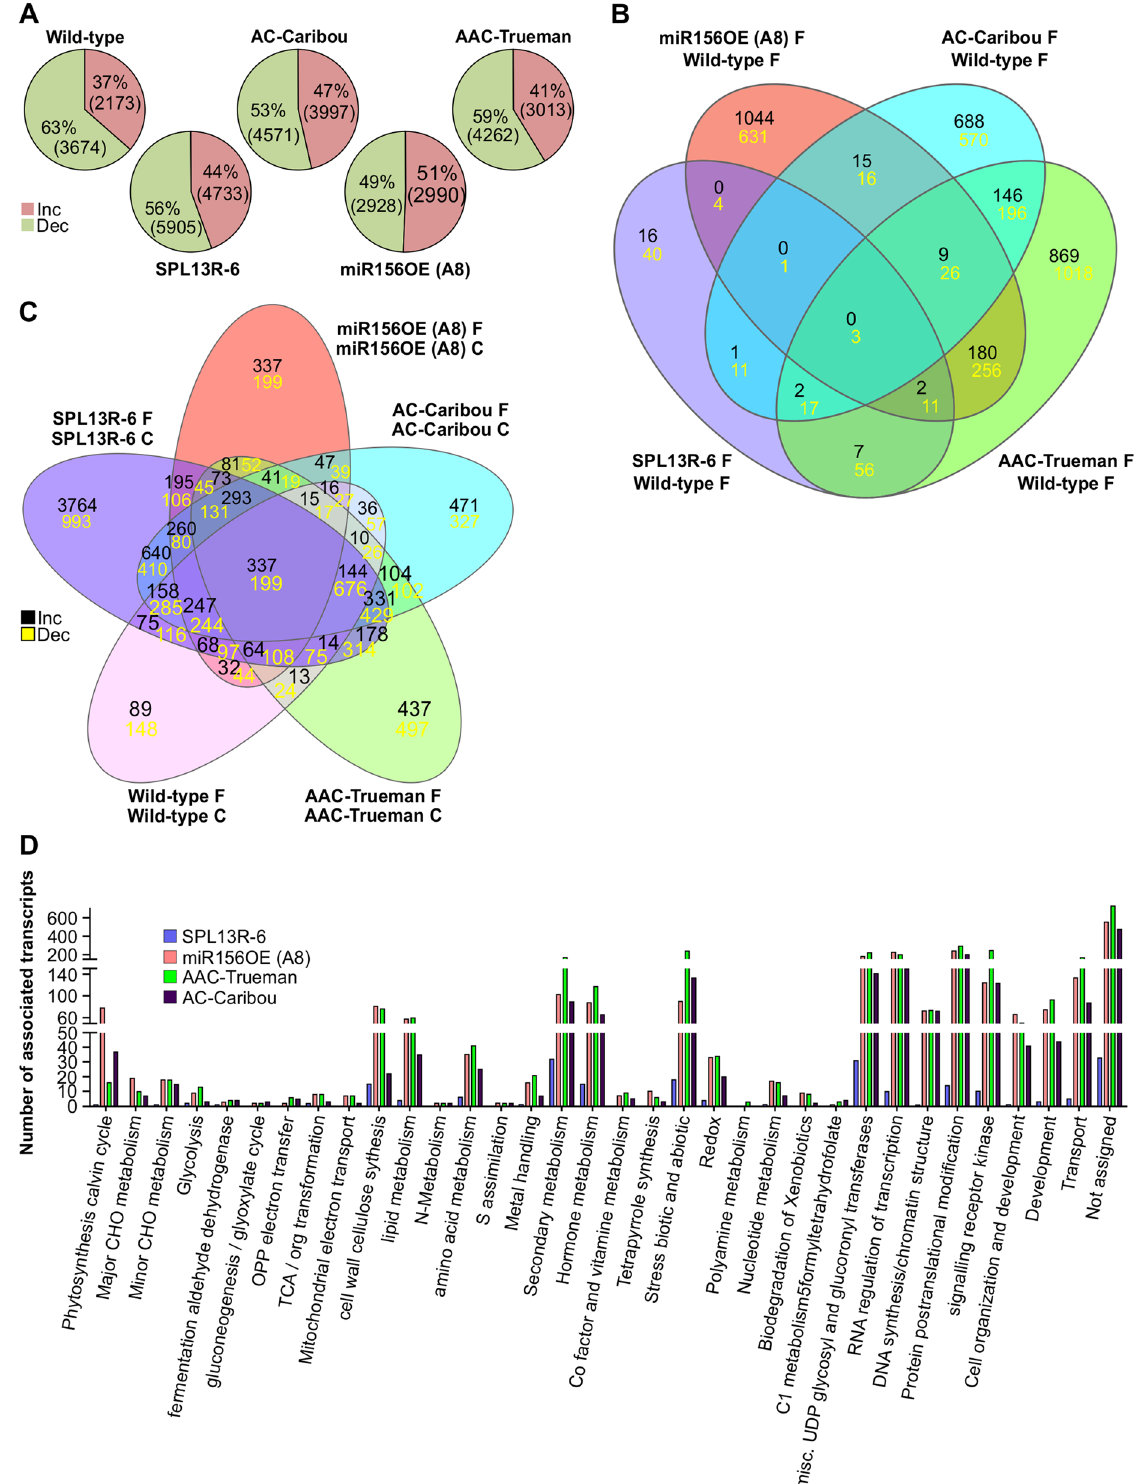
Figure 3. Differentially expressed genes and their associated function upon flood stress in alfalfa. ( A ) Differentially expressed genes, DEG, in each genotype comparing flooding and well-drained control alfalfa plants, ( B ) Venn diagram illustrating commonality and uniqueness in DEG obtained by comparing flood-stressed WT to AC-Caribou, AAC-Trueman, SPL13 RNAi-6 and miR156 -A8 genotypes independently upon flooding, ( C ) Venn diagram illustrating commonly shared and unique DEG obtained by comparing flood-stressed and their respective well-drained control counterparts plants of each genotypes, ( D ) functional distribution of DEG generated by comparing flood-stressed WT to AC-Caribou, AAC-Trueman, SPL13 RNAi-6 and miR156 -A8 genotypes. Upper and lower panel numbers in ‘ B ’ and ‘ C ’ indicate increased and decreased DEG, respectively, compared to WT flood stress or the same genotype under control conditions respectively. Novaseq 6000-based RNAseq analysis was performed for three biological replicates for each treatment condition and genotype. Venn diagram was constructed using an online tool http:// www. inter activ enn. net/ from